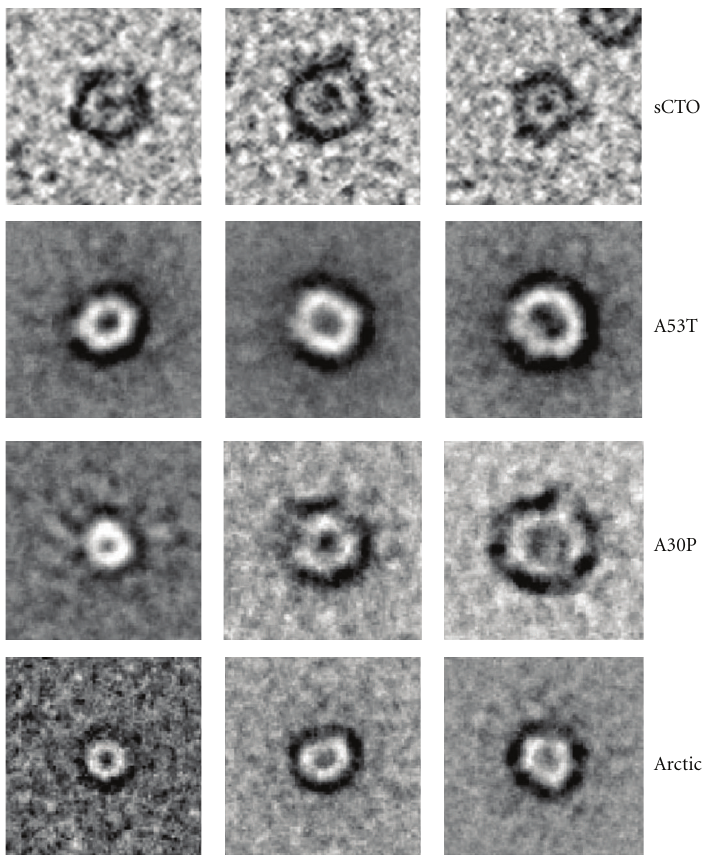
Figure 4: EFTEM of sCTOs. Annular sCTOs show remarkable morphologic similarities with amyloid pores of mutant α -syn (A53T and A30P) and A β (Arctic). TEM images of α -syn and A β were reproduced with permission from